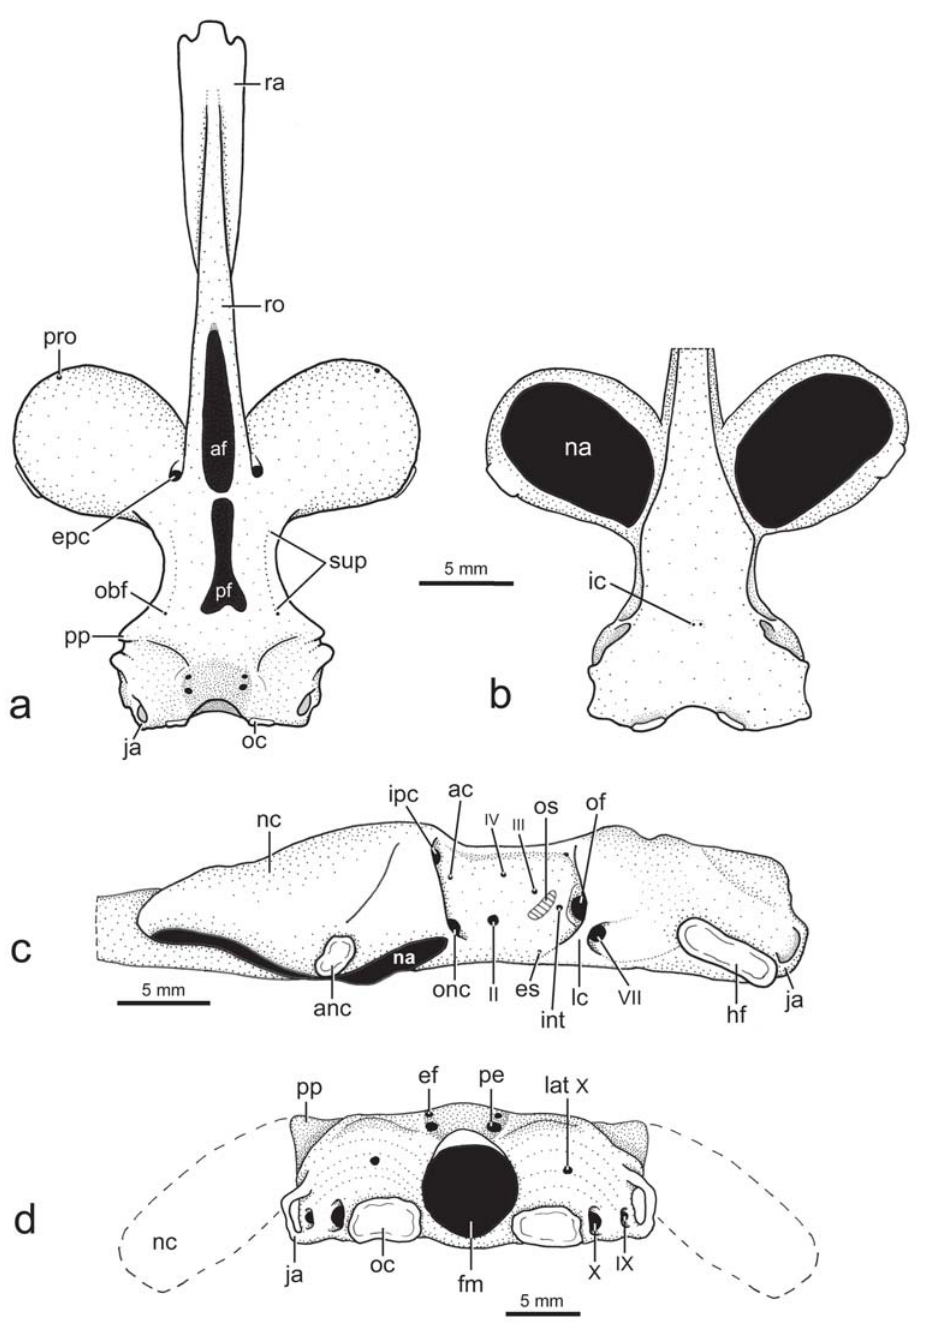
Fig. 9. Neurocranium of Malacoraja obscura , n. sp. (MNRJ 28292, 295 mm TL) in (a) dorsal, (b) ventral, (c) lateral, and (d) posterior views. Rostrum omitted in (b). Abbreviations: ac , anterior cerebral vein foramen; af , anterior fontanelle; anc , antorbital cartilage condyle; ef , endolymphatic foramen; epc , external preorbital canal; es , efferent spiracular artery foramen; fm , foramen magnum; hf , hyomandibular facet; ic , internal carotid foramina; ja , jugal arch; int , interorbital vein foramen; ipc , internal preorbital canal; lat X , lateralis branch of vagus nerve foramen; lc , lateral commissure; na , nasal aperture; nc , nasal capsule; obf , internal foramen for otic branch of facial nerve; oc , occipital condyle; of , orbital fissue; onc , orbitonasal canal; os , optic stalk; pe , perilymphatic foramen; pf , posterior fontanelle; pp , postorbital process; pro , foramen for profundus nerve; ra , rostral appendix; ro , rostrum; sup , superficial ophthalmic nerve foramina; II , optic nerve foramen; III , oculomotor nerve foramen; IV , trochlear nerve foramen; VII , hyomandibular branch of facial nerve foramen; IX , glosspharyngeal nerve foramen; X , vagus nerve foramen. Anterior toward top in (a) and (b); anterior toward left in